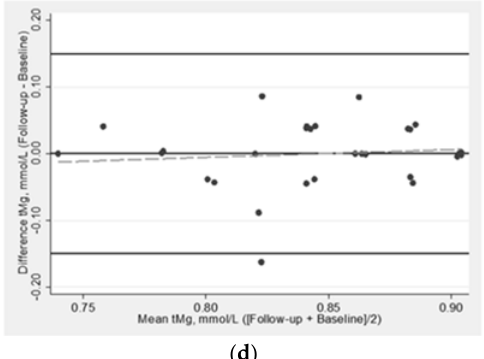
Figure 2. Bland ‐ Altman plot assessing the ( a ) change in ionized magnesium in response to magnesium supplementation over 10 weeks in the treatment arm, n = 22; ( b ) change in total magnesium in response to magnesium supplementation over 10 weeks in the treatment arm, n = 24; ( c ) change in ionized magnesium in response to magnesium supplementation over 10 weeks in the placebo arm, n = 27; ( d ) change in total magnesium in response to magnesium supplementation over 10 weeks in the placebo arm, n = 30. Normalized iMg concentration, which is adjusted for blood pH. Solid lines (black) are the mean difference ± 3 standard deviations; the long dash line (gray) is the fitted values; the short dash line (black) is the reference line for the mean difference of 0 mmol/L.